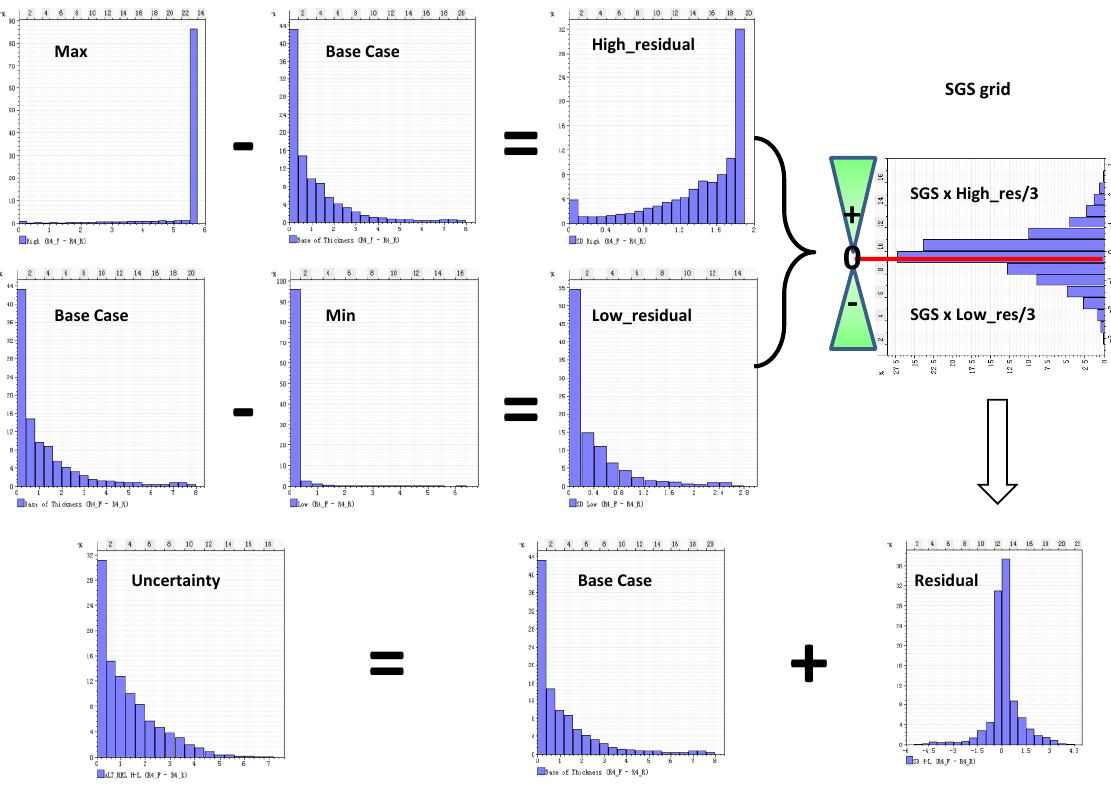
Figure 2—Procedure to quantify the uncertainty of coal